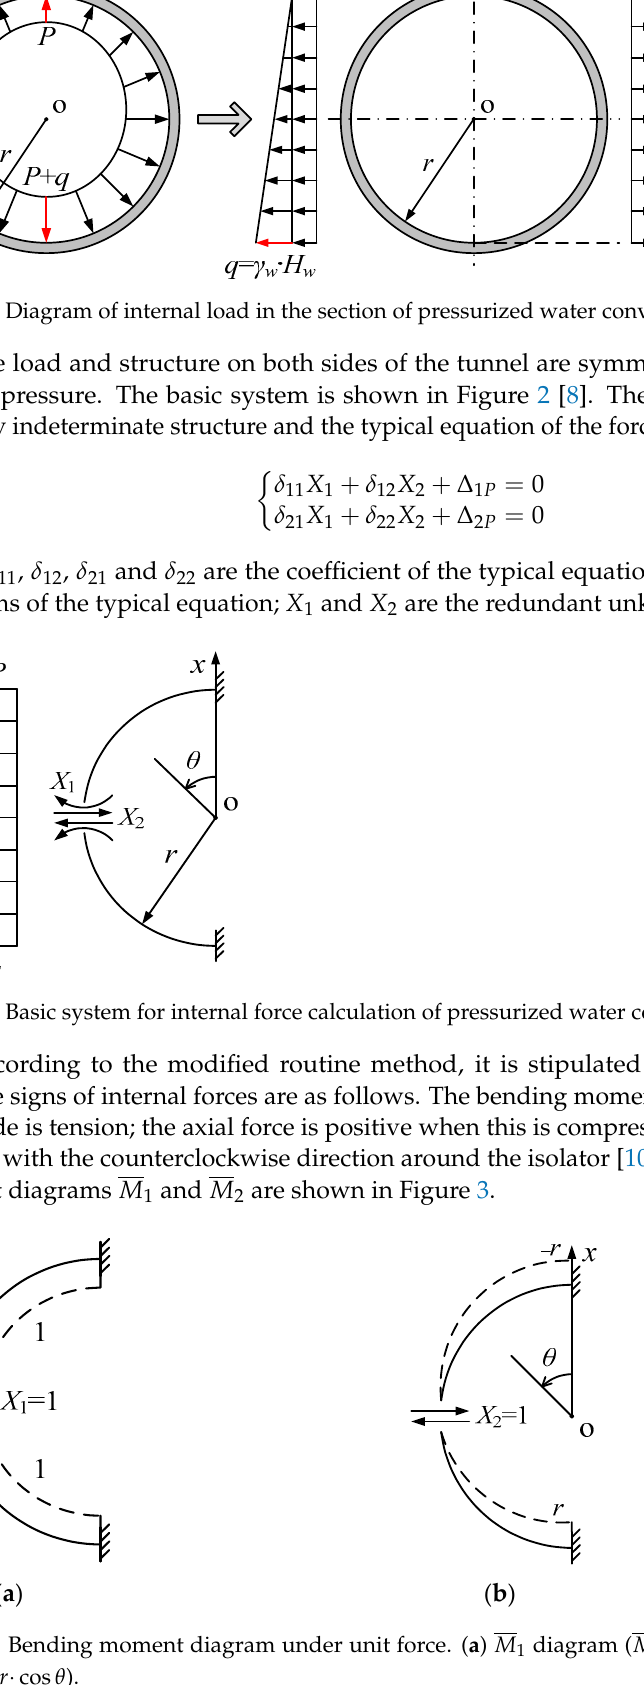
Figure 1. Diagram of internal load in the section of pressurized water conveyance tunnel.